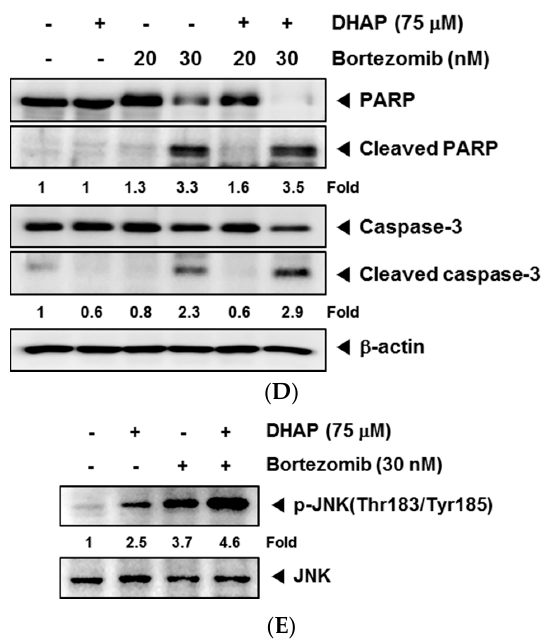
Figure 4. Effect of DHAP on bortezomib-induced apoptosis in U266 cells. ( A ) The cells were treated with DHAP (0, 25, 50, and 75 μ M) and bortezomib (0, 15, 20, and 30 nM) for 48 h. MTT assays were used to determine the cytotoxicity ( left ). The DHAP synergistically enhanced the bortezomib-induced cell death in U266 cells ( right ). The average of the CI values was calculated from nine separate combinations. A CI of less than 1 was regarded as synergistic, a CI of 1 was regarded as additive, and a CI greater than 1 was regarded as antagonistic. U266 cells were treated simultaneously with 75 μ M of DHAP and 20 and 30 nM of bortezomib for 48 h; ( B ) The cells were incubated with an FITC-conjugated Annexin V, then analyzed with flow cytometry for apoptotic effect; ( C ) Bcl-xl, Bcl-2, Mcl-1, Survivin, IAP1, COX-2, Cyclin D1, Cyclin E, and MMP-9 protein levels were determined by Western blot analysis; ( D ) PARP and caspase-3 protein levels were ascertained via Western blot analysis. To confirm equal protein loading, the immunoblot was stripped and reprobed for β -actin; ( E ) U266 cells were treated simultaneously with 75 μ M of DHAP and 30 nM bortezomib for 12 h, following which whole-cell extracts were created and examined for p-JNK (Thr183/Tyr185) via Western blot analysis. To confirm equal protein loading, the immunoblot was stripped and reprobed for total JNK protein. Densitometric quantitation in fold change of each band has been indicated below the gel. ## p < 0.01, ### p < 0.001, vs. control, * p < 0.05, ** p < 0.01, *** p < 0.001, vs. bortezomib alone.